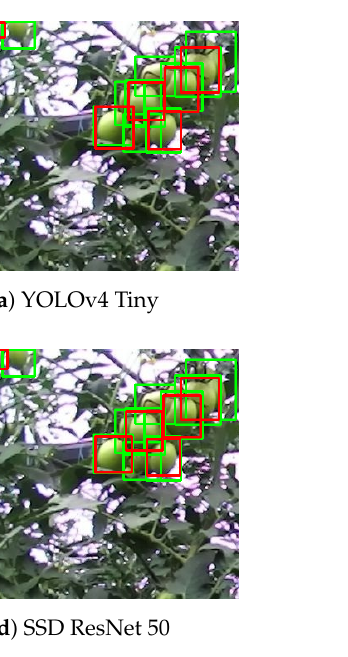
Figure 16. Result comparison for overlapped